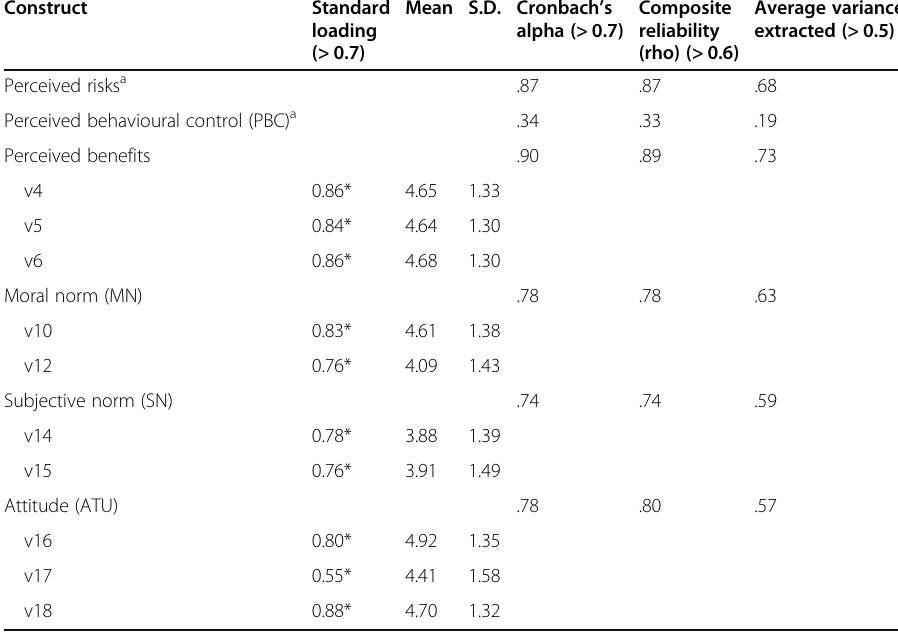
Table 5 Alternative protein source: measurement properties of the multi-item constructs ( N = 1816) Construct